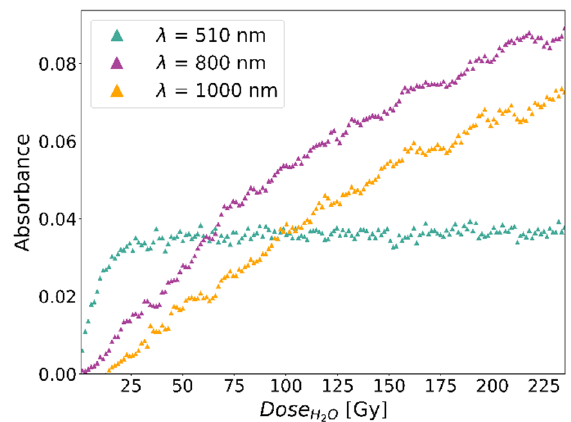
Figure 6. Absorbance as a function of the dose for the dosimeter with EBT3 gafchromic film for the dose measurement of the radiation field from a 90 Sr/ 90 Y beta source.